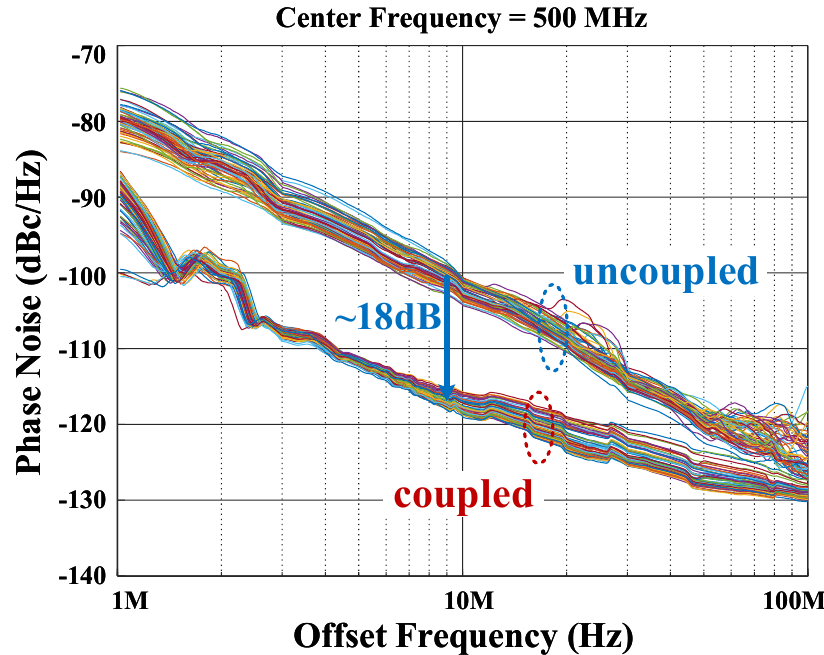
Figure 19. Measured phase noise comparison, for uncoupled and coupled conditions, for all 64 ROs at 500MHz center